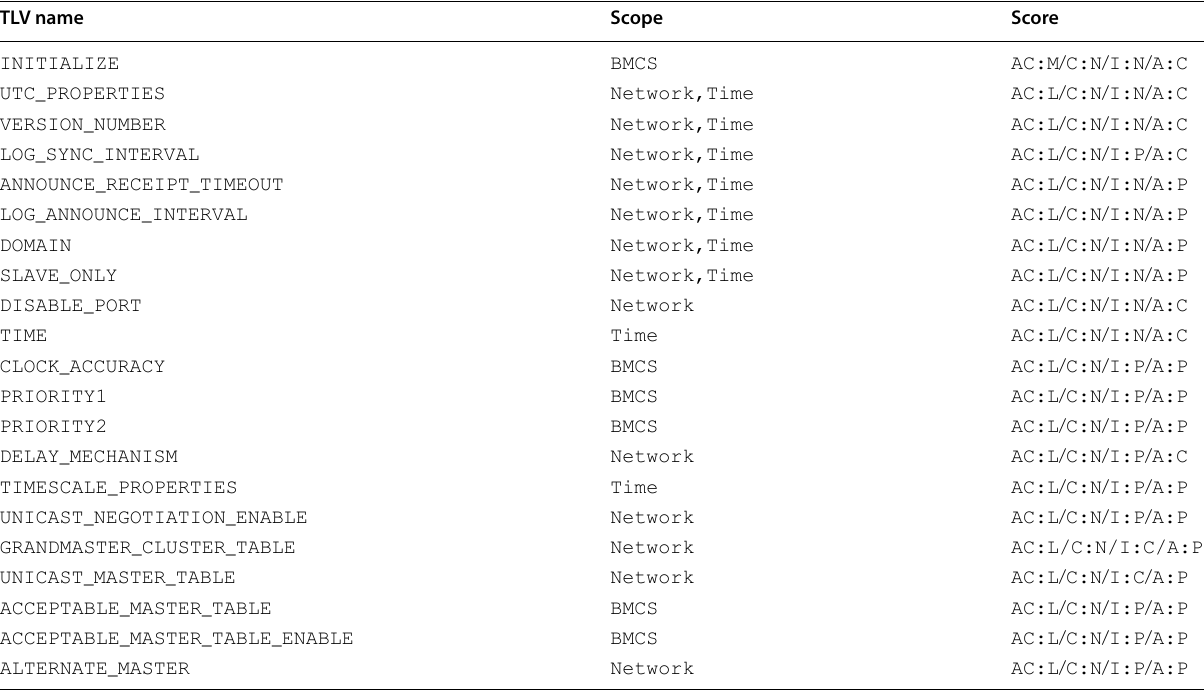
Table 3 PTP IEEE-1588 2008 TLVs that can be used to exploit the network